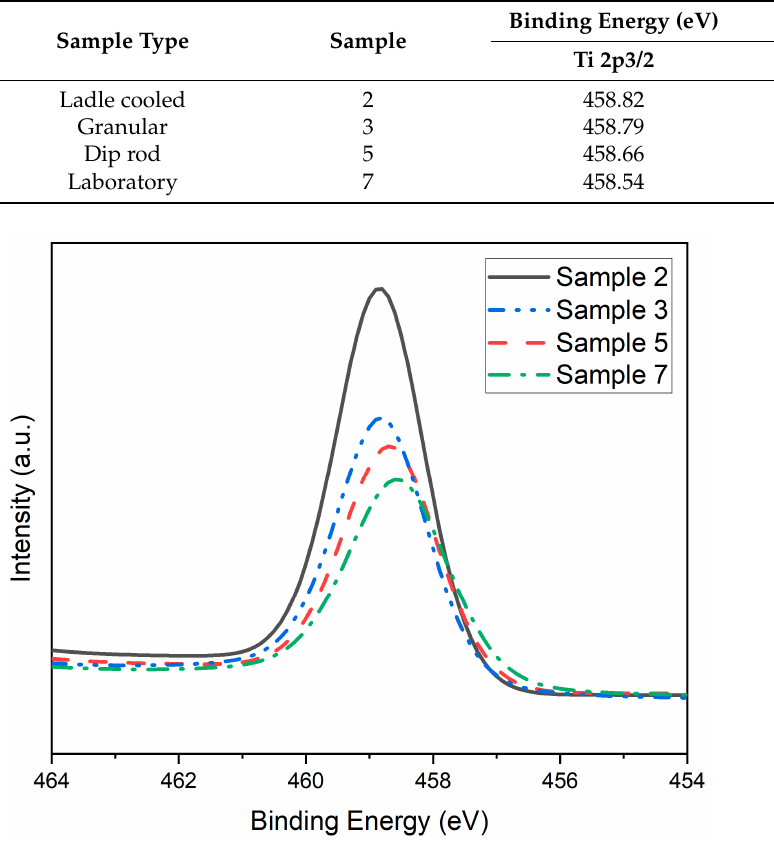
Figure 6. Results of the XPS analysis showing the binding energy of the Ti 2p3/2 for four samples from each category. from each